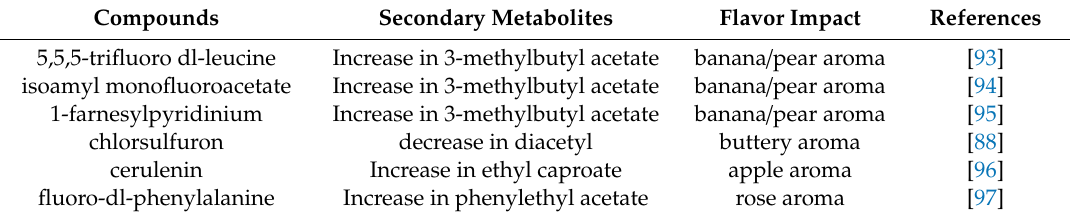
Table 1. “Directionless” evolutionary engineering approaches for improving flavor-related